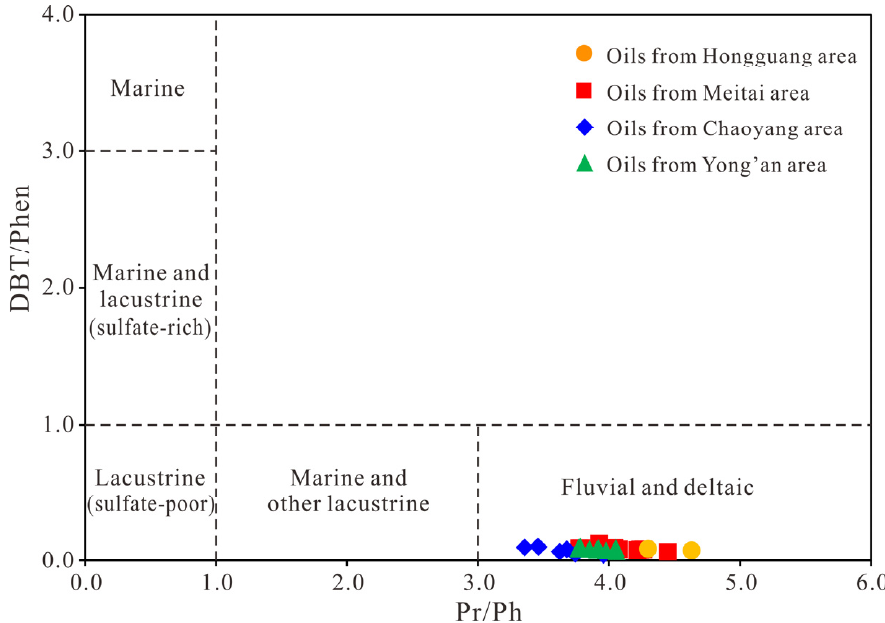
Figure 4. A cross-plot of dibenzothiophene/phenanthrene (DBT/Phen) vs. pristane/phytane (Pr/Ph) ratios for oils from Huangtong Sag (After Hughes et al., 1995 [26]).